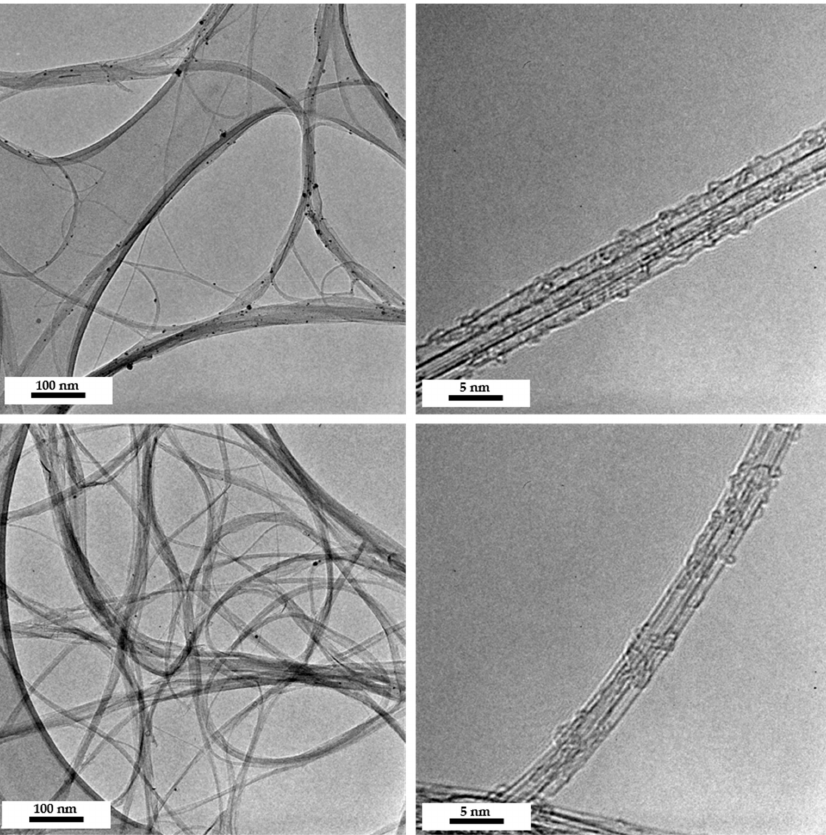
Figure 1. TEM images of pristine single-walled carbon nanotube (SWCNT) Tuball TM ( top , reprinted from [28]) and B-SWCNT ( bottom